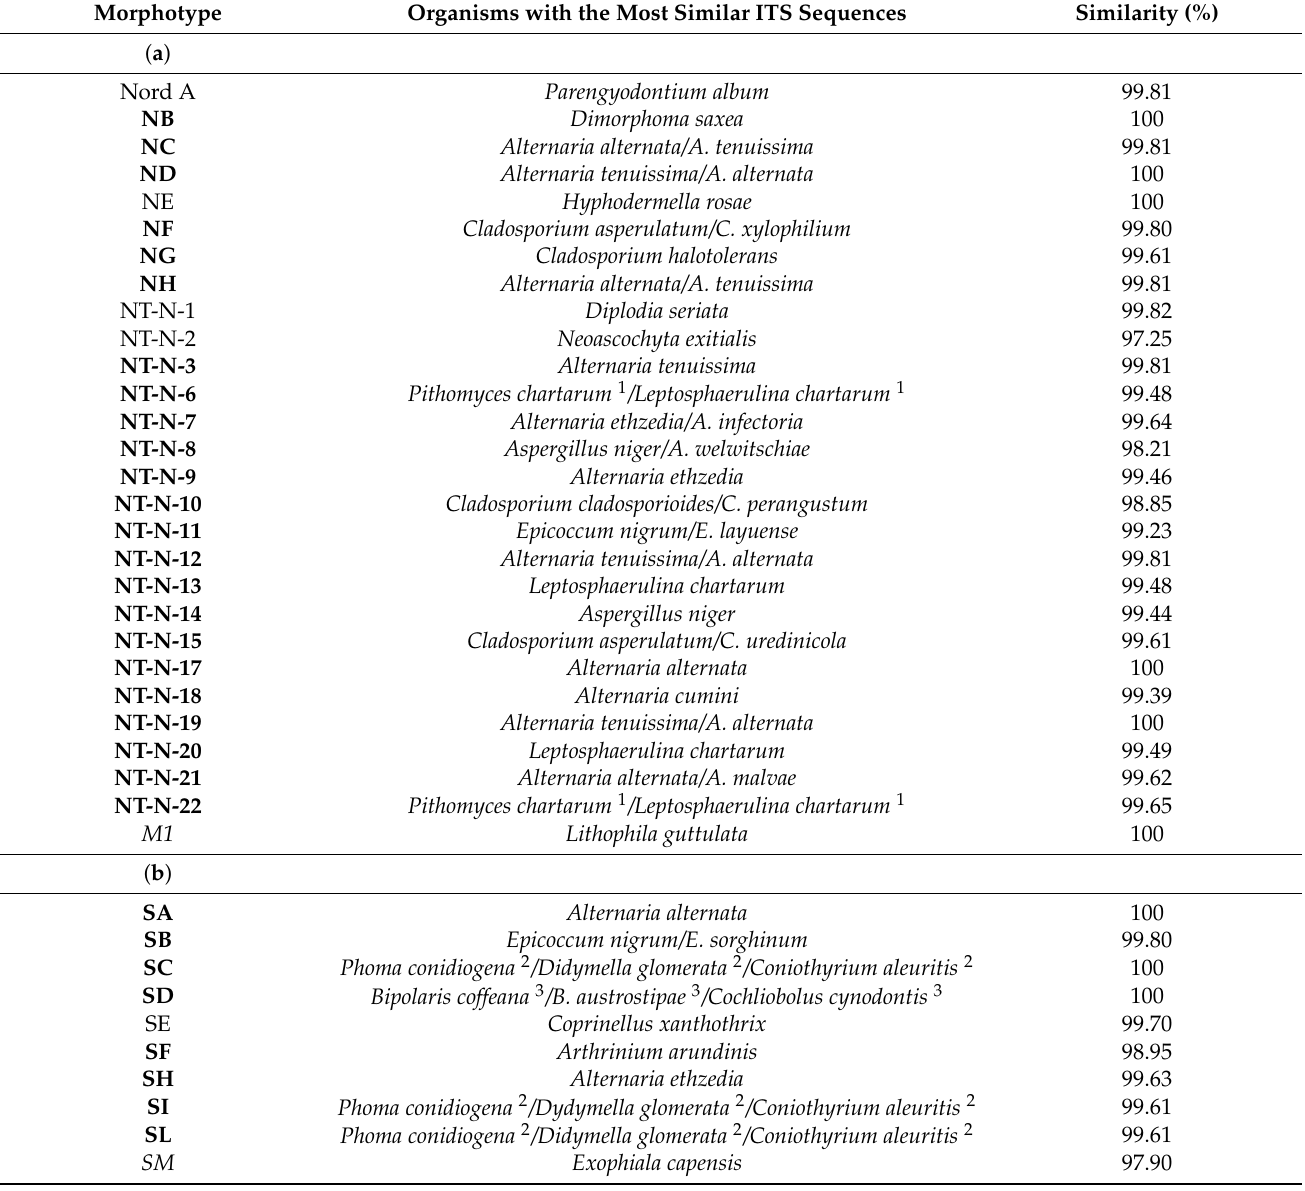
Table 1. Identification of fungi isolated at the NW and SE study sites of SMFC by rDNA analysis. ( a ) Morphotypes isolated at the NW site. ( b ) Morphotypes isolated at the SE site. In the Morphotype column, bold indicates dematiaceous filamentous fungi; italics indicate dematiaceous meristematic fungi and black